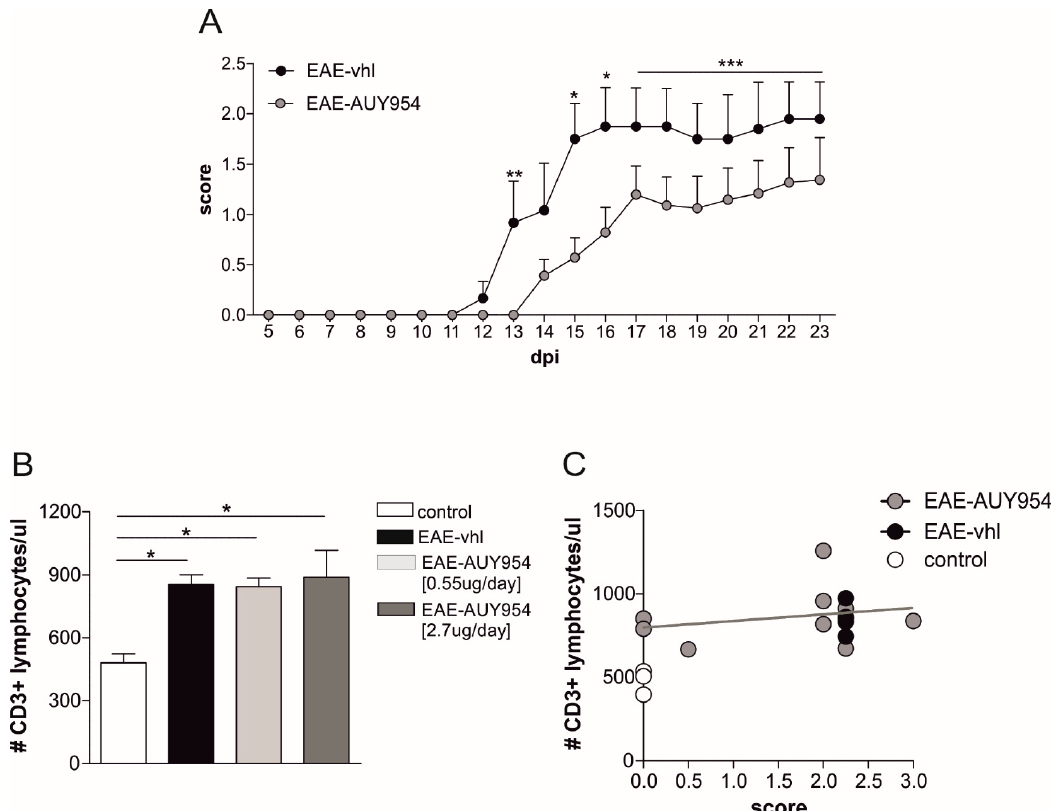
Figure 7. AUY954 icv treatment ameliorates EAE clinical disability without affecting T cell absolute count. ( A ) The graph shows representative clinical course of EAE mice treated for four weeks with two different AUY954 dosages (2.7 μ g/day and 0.55 μ g/day) or vehicle, preventively delivered by icv infusion. AUY954 icv treatment significantly ameliorated EAE disease progression. Mann-Whitney test on day 13, 15, 16, and from 17 to 23 days post immunization (dpi) by cumulating the data, * p < 0.05; ** p < 0.01; *** p < 0.001). ( B ) CD3+ lymphocytes were counted in the peripheral blood of EAE mice (21 dpi) receiving vehicle (vhl) or different AUY954 dosages, 2.7 μ g/day and 0.55 μ g/day. No significant reduction was observed at any dosage in comparison to EAE-vhl mice. Conversely, T cell count was significantly less in healthy mice in comparison to other EAE groups. Data are presented as mean ± SEM; ANOVA Tukey’s p < 0.05. ( C ) Statistical analysis between clinical score and T cell count shows the lack of correlation between these two parameters in AUY954-EAE mice (r 2 = 0.06).